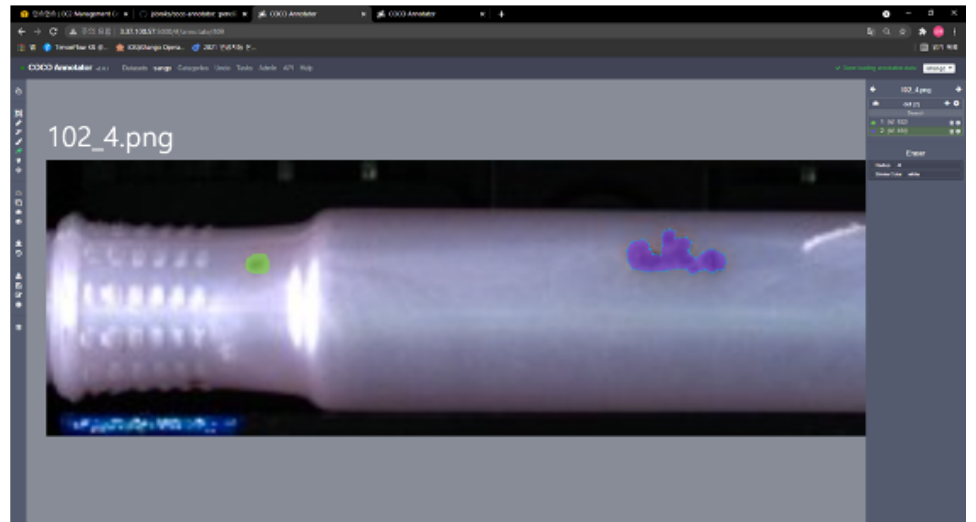
Figure 13. Example of data annotation with image segmentation